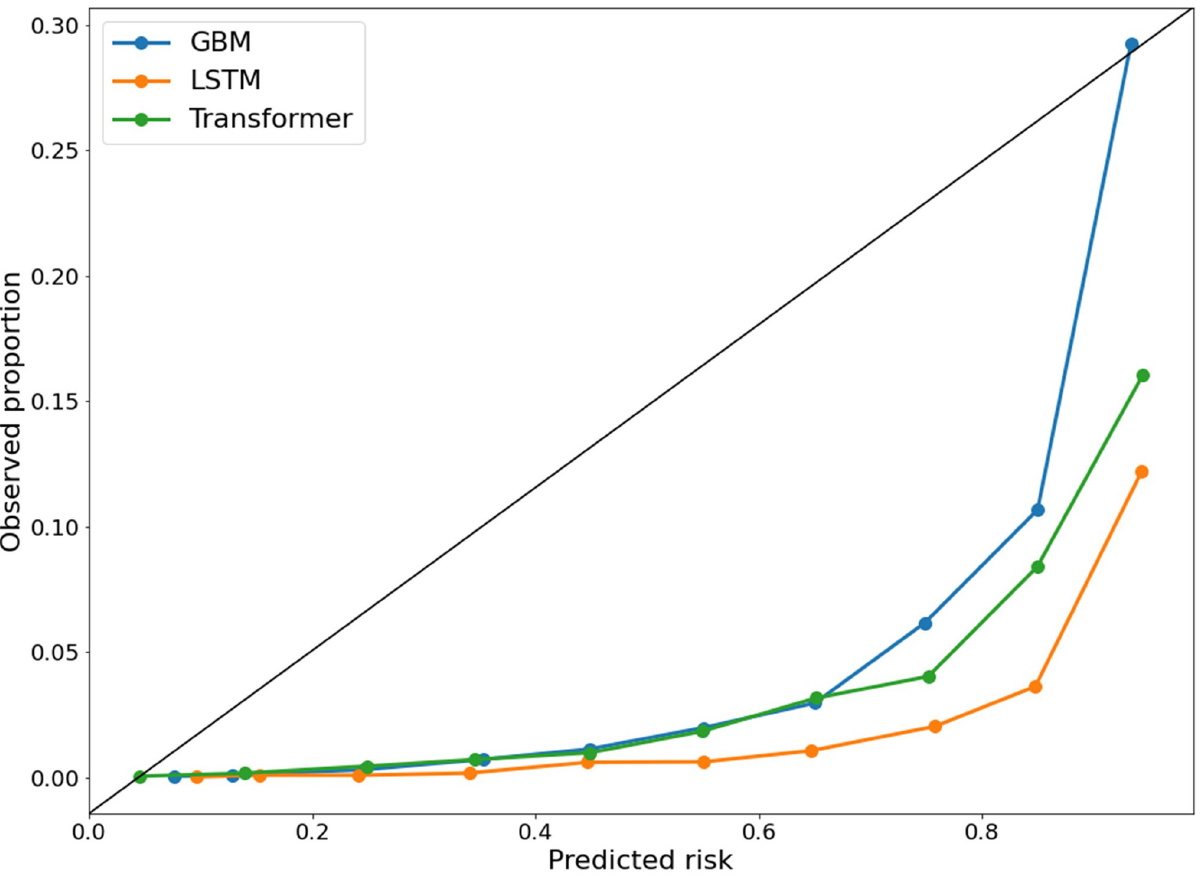
Fig 3. Calibration plot of the prediction in the holdout validation cohort. GBM, Gradient-boosting model; LSTM, Long short-term